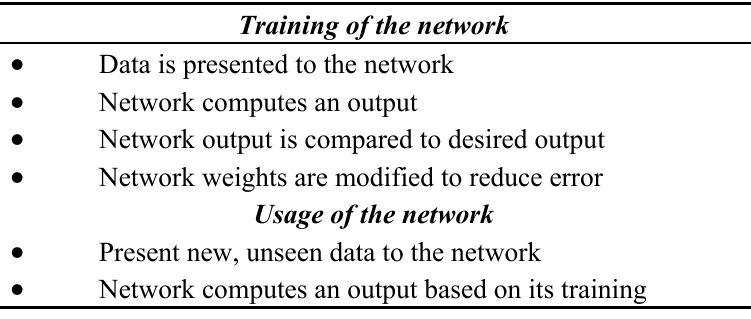
Table 1. Steps in the supervised network training and